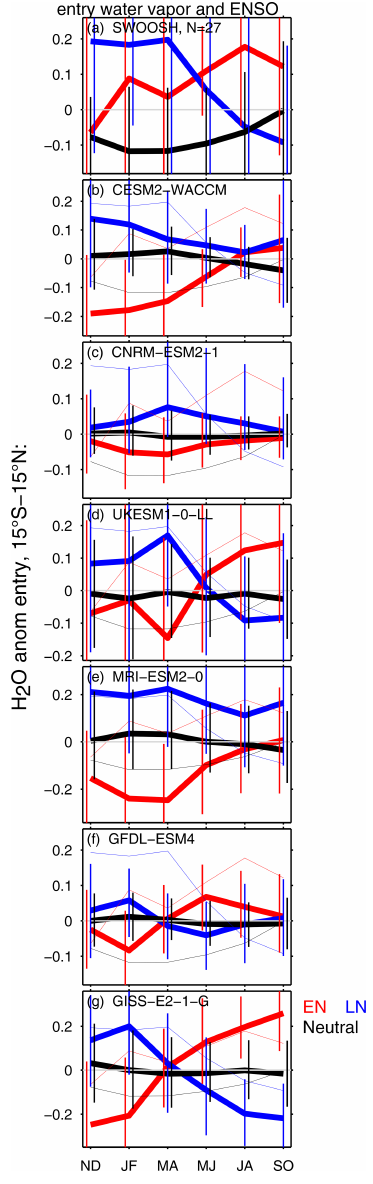
Figure 7. (a) As in Fig. 2a but for SWOOSH at 68hPa. (b–g) As in Fig. 2 but subsampling the model output for six CMIP6 models with interactive chemistry to match the sample size in observations for each ENSO phase for water vapor at